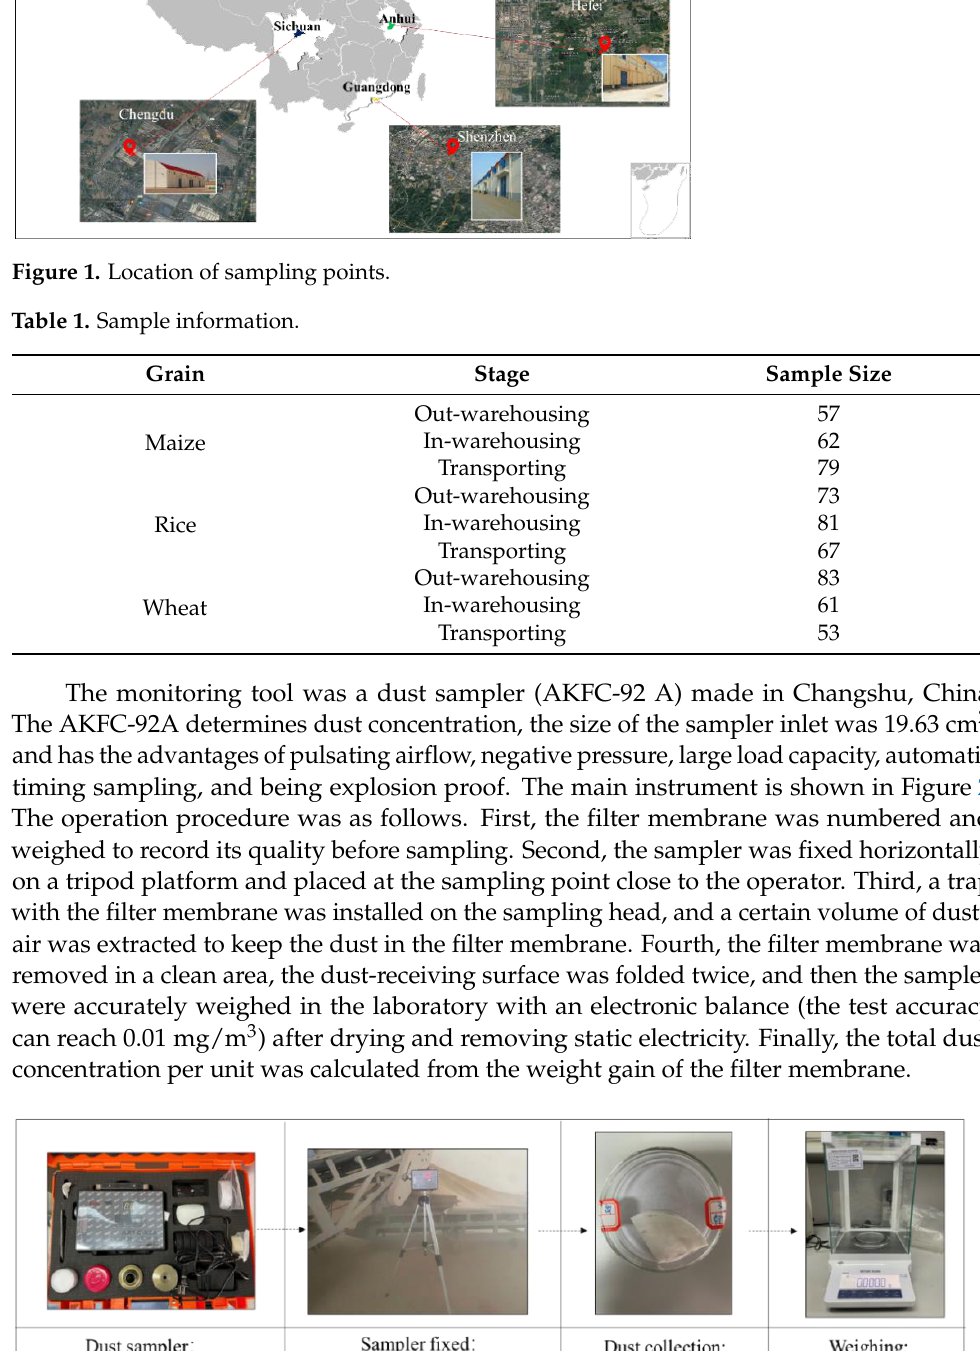
Figure 3. Dust damage model. 2.2.1. Dust Exposure Dose The dust exposure dose refers to the assessment of individual exposure parameters, which is calculated by monitoring the concentration of dust, exposure duration, and ex- posure method. However, China has not yet established a complete human exposure pa- rameter database, therefore, due to this lack, the exposure parameter method proposed